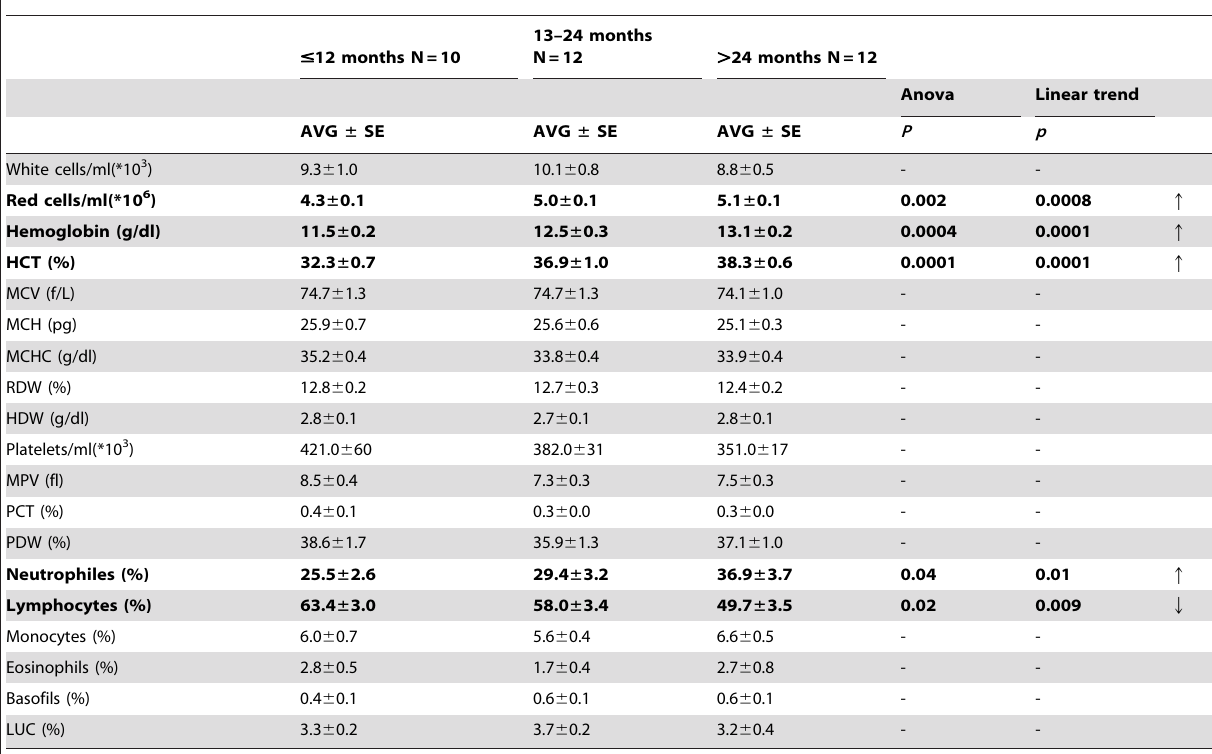
Table 1. Hematologic profile in hemangioma patients, in three